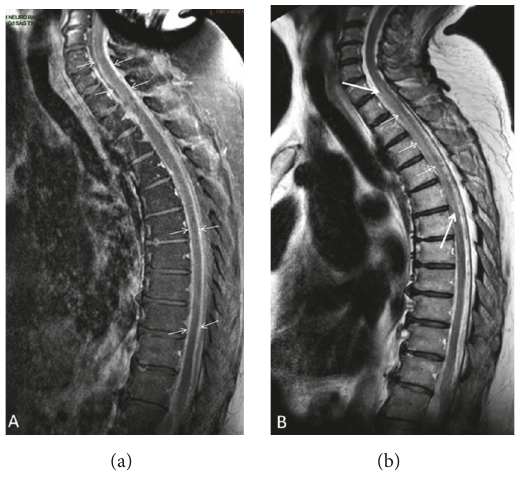
Figure 2: Follow-up MR examination of the cervicodorsal seg- ments. (a) Midsagittal CE T1-weighted view showing strong enhancement of both dura and pia (between arrows) surrounding spinal cord. (b) Midsagittal T2-weighted view showing relative hypersignal intensity within upper anterior spinal artery territory between T1/T2 and T5/T6 disks (arrows) corresponding to spinal cord